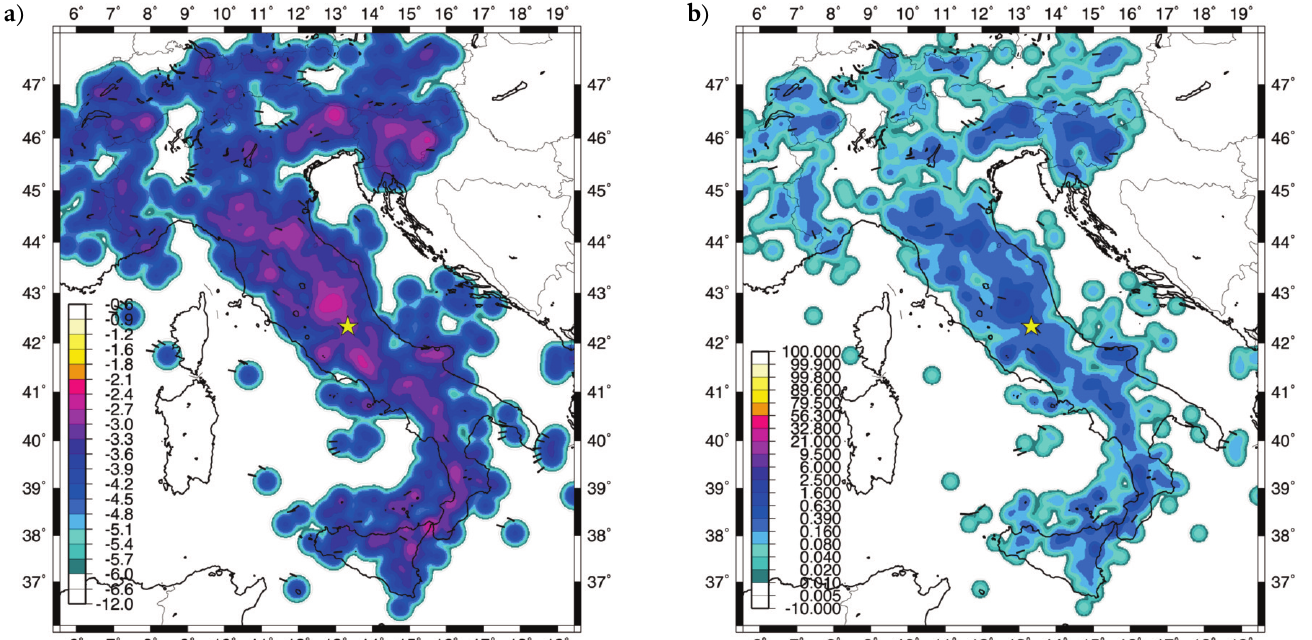
≥ 5.0 events per year in each cell) for the Figure 7. (a) Forecast seismicity rates obtained using a 15 km correlation distance (expected number of M L ≥ 4.3 earthquakes from 1100 to 2003. Yellow asterisk, main shock from the April 6, 2009, L'Aquila CPTI04 case, using the spatially smoothed location of M L ≥ 5.0 predicted in 10 km × 10 km cells around each location. Earthquake rates earthquake. (b) Five-year probabilities as log rates of events per year for M 10 L per km2 can be obtained by multiplying by 10 −2 . For the recurrence time of the seismic activity we assumed a time-independent (Poisson) model, in which the occurrence of an earthquake does not change the probability of occurrence of following events.